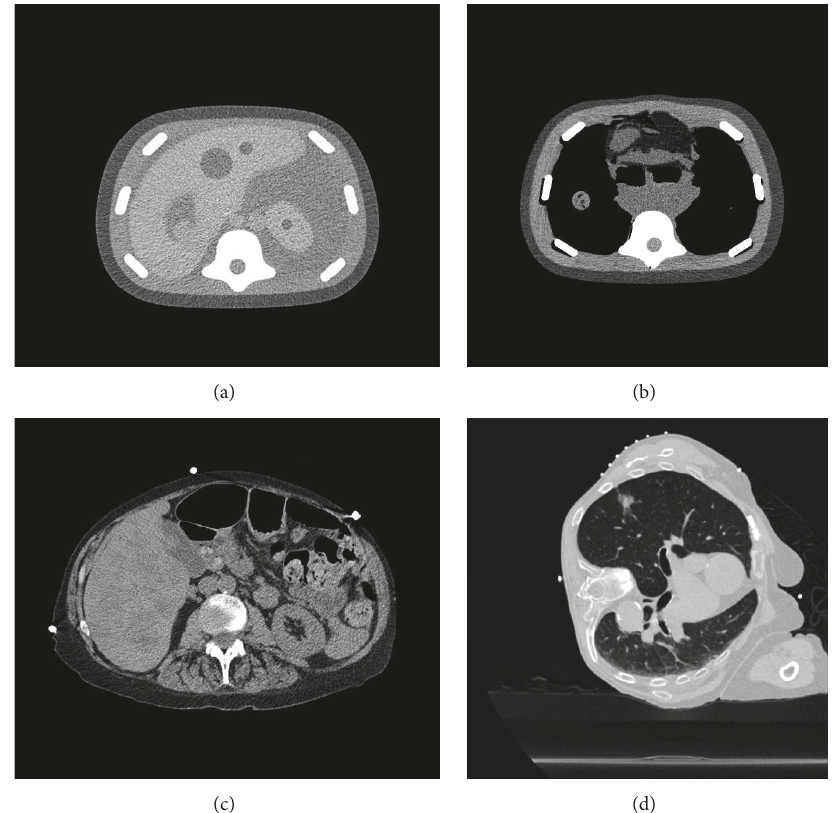
Figure 1: Sample of preprocedural CTs: (a) phantom abdominal scans; (b) phantom thoracic scans; (c) patient abdominal scan; (d) patient thoracic